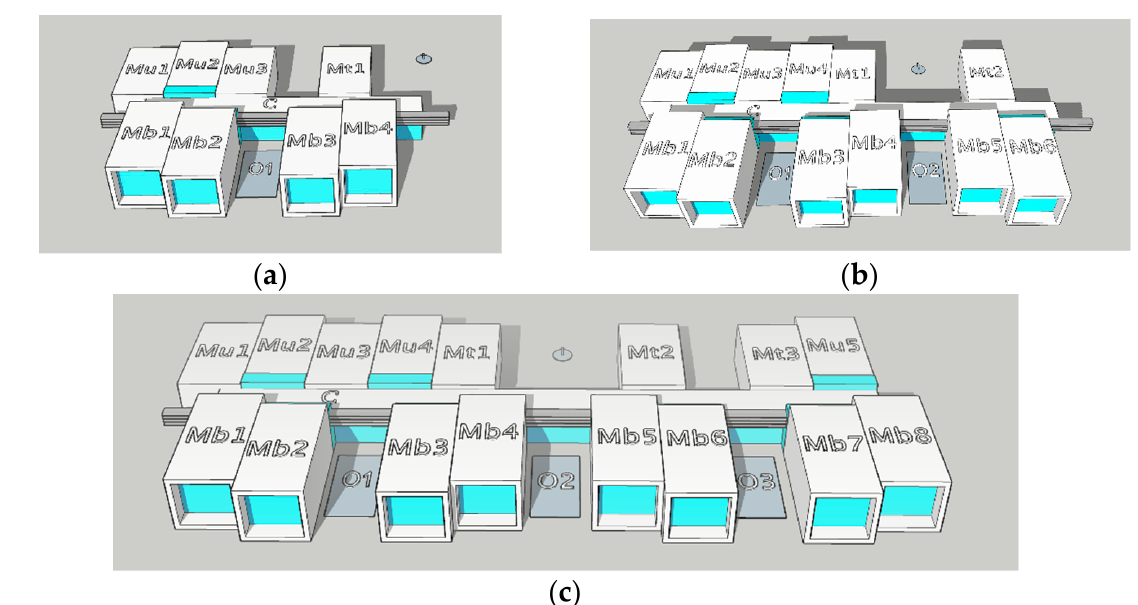
Figure 8. Three development stages for balneotherapy facility: ( a ) Stage 1 with 4 balneotherapy units, ( b ) Stage 2 with 6 balneotherapy units, and ( c ) Stage 3 with 8 balneotherapy units.